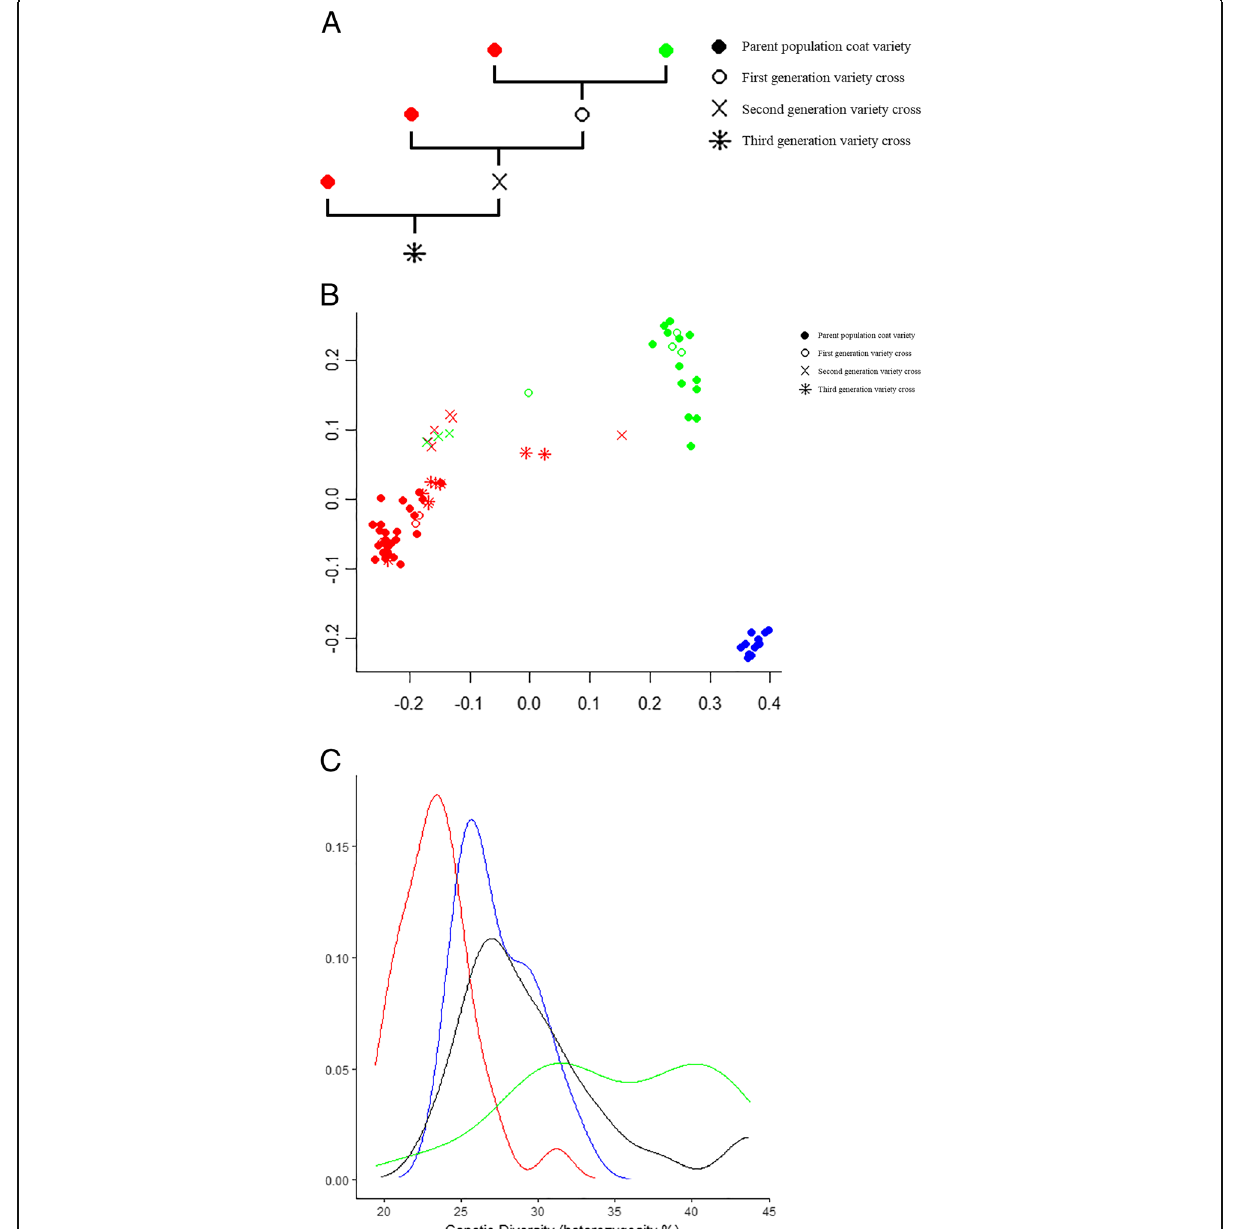
Fig. 1 Genetic relationship and diversity in the Dutch Shepherd Dog. a Crossbreeding of short haired and long haired Dutch Shepherd Dogs. Parent populations of short haired (green) and long haired (red) dogs were matched to produce first generation variety crosses. Matching variety crosses with a parent population (backcross) resulted in the next generation of variety crosses. b Genetic relationship of the tested population of Dutch Shepherd Dogs in a multidimensional scaling plot. The parent populations shown are short haired (green, n =13), long haired (red, n =28), and wire haired (blue, n =13) varieties. Variety crosses are shown in the colour of the genetically confirmed coat variety (trait testing MyDogDNA ™ ). c Genetic diversity of the tested population of Dutch Shepherd Dogs. The short haired (green, n =18), long haired (red, n =46), and wire haired (blue, n =16) are shown together with a combination of the variety crosses between long and short haired (black, n